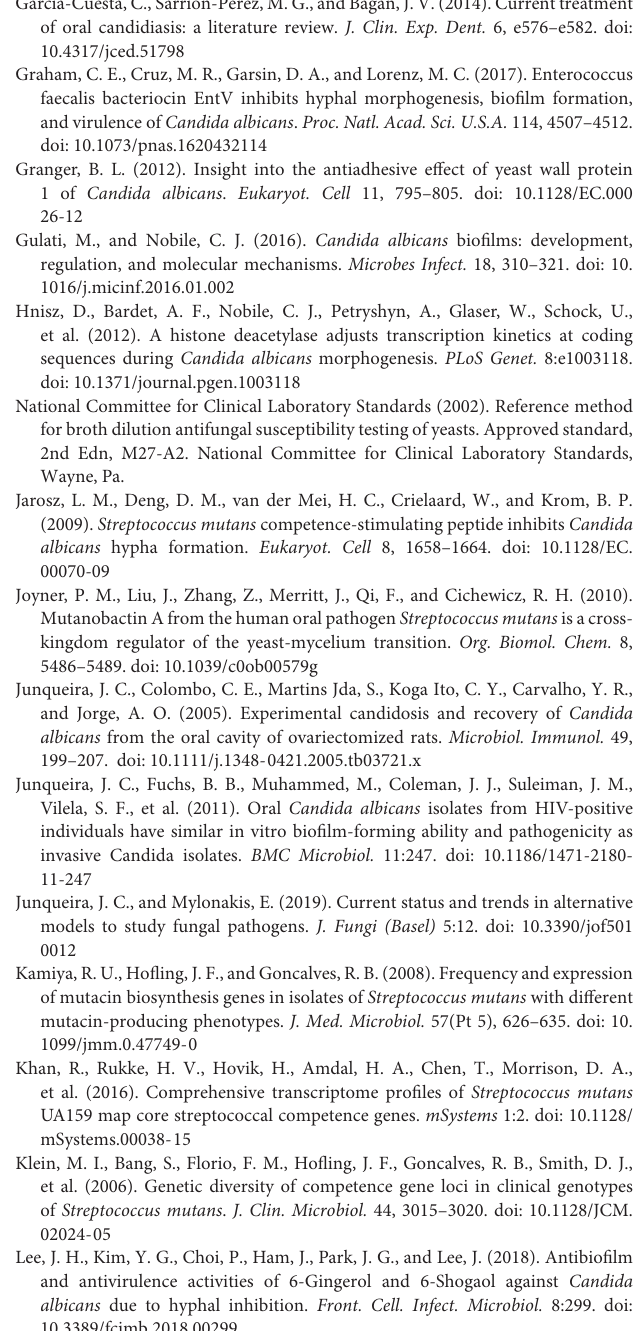
are different between the SM-F1 and control. The blue arrows show the peaks of SM-F1 that indicate the identified compounds. FIGURE S6 | Chromatograms obtained by gas chromatography coupled to mass spectrometry (GC-MS). Comparisons between the SM-F2 fraction (pink) and control group of BHI media (black). The black arrows indicate the peaks that are different between the SM-F2 and control. The blue arrows show the peaks of SM-F2 that indicate the identified